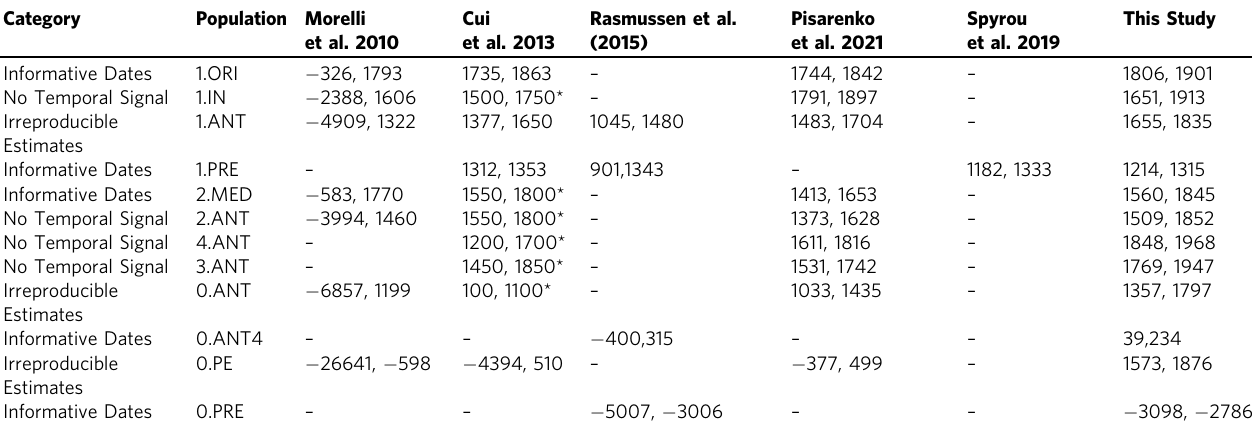
Table 1 Bayesian estimates of the time to most recent common ancestor (tMRCA) across Y. pestis